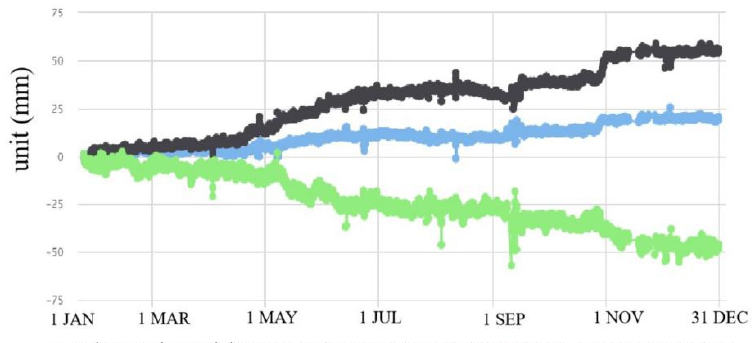
Figure 9. Displacements recorded by GPS 06 in 2016.